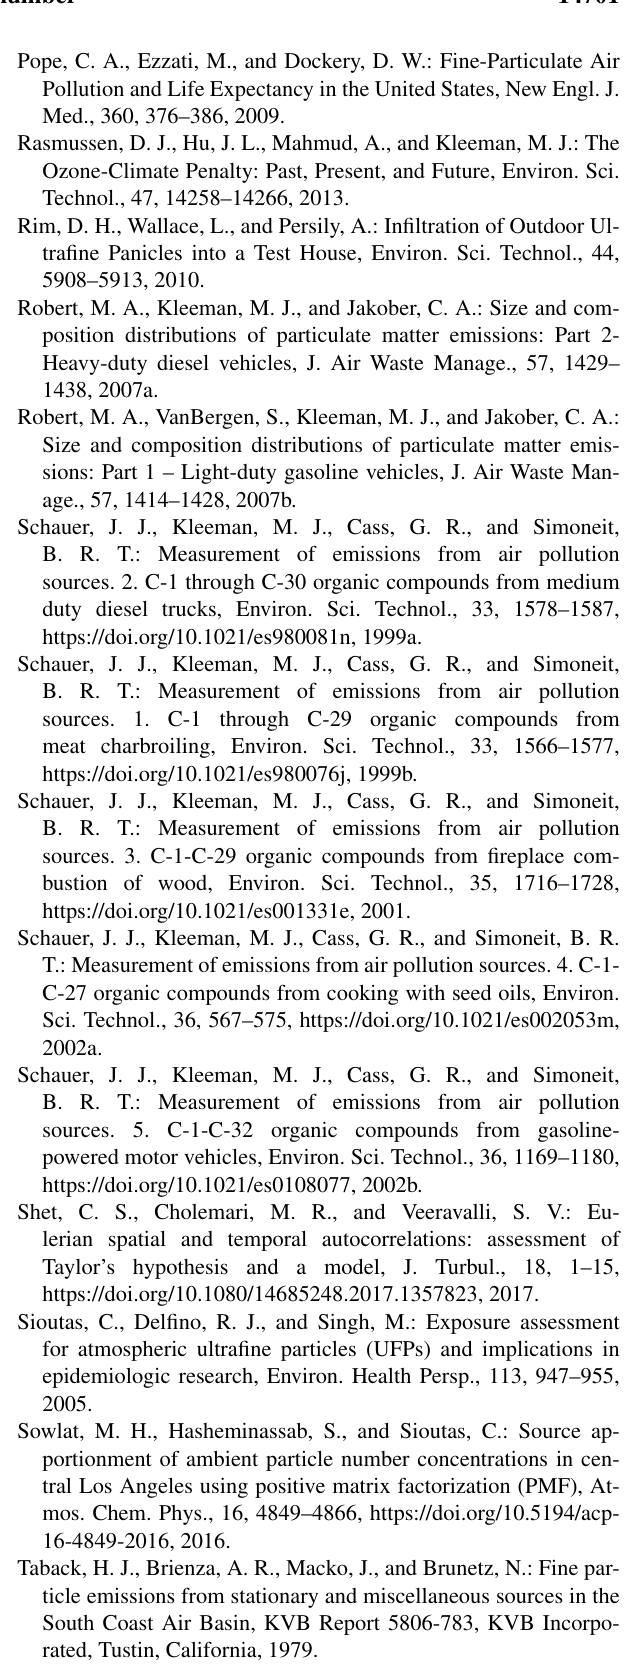
Taback, H. J., Brienza, A. R., Macko, J., and Brunetz, N.: Fine